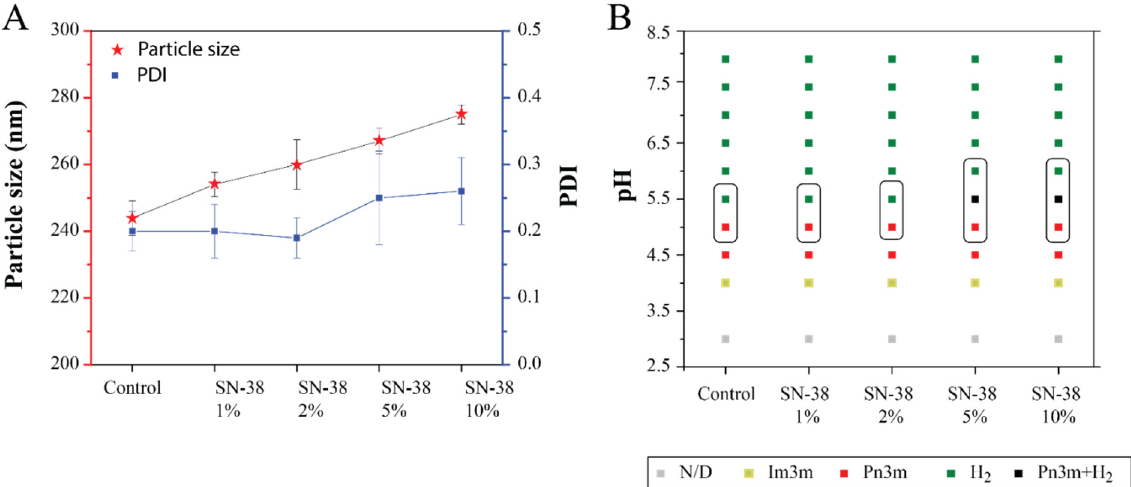
Figure 6. ( A ) Particle size and size distribution (PDI) of SN-38-loaded MO + OAPy-4 LNP. The control sample was LNPs without SN-38. The LNPs were prepared by adding 1, 2, 5, and 10 wt.% of SN-38 to the total quantity of lipid mixture consisting of MO and OAPy-4, which were stabilised by Pluronic F-127. The experiments were performed in triplicate, and the results were reported as the mean ± standard deviation. ( B ) A partial phase diagram for SN-38-loaded LNPs with respect to pH at 37 °C. The boxes represent the phase transition from H 2 to Q 2 with the decrease in pH.